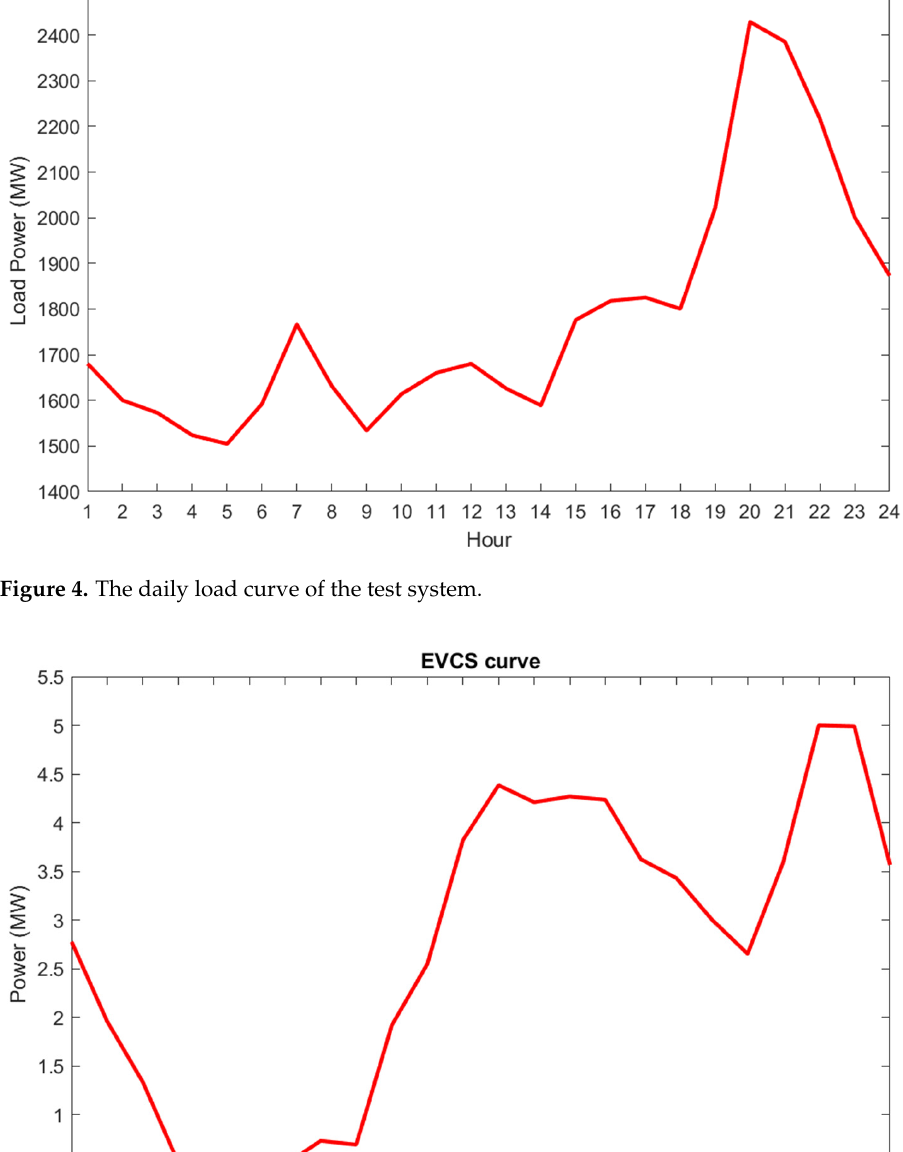
Figure 6. The daily curve of solar PV power generation. Table 1. Necessary parameters of the ESS for the calculation. Parameters